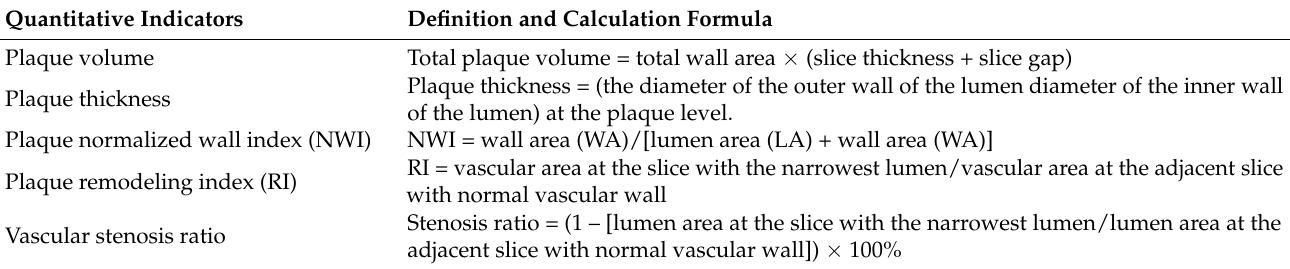
Table 1. The definition and calculation formula of the quantitative indicators of carotid